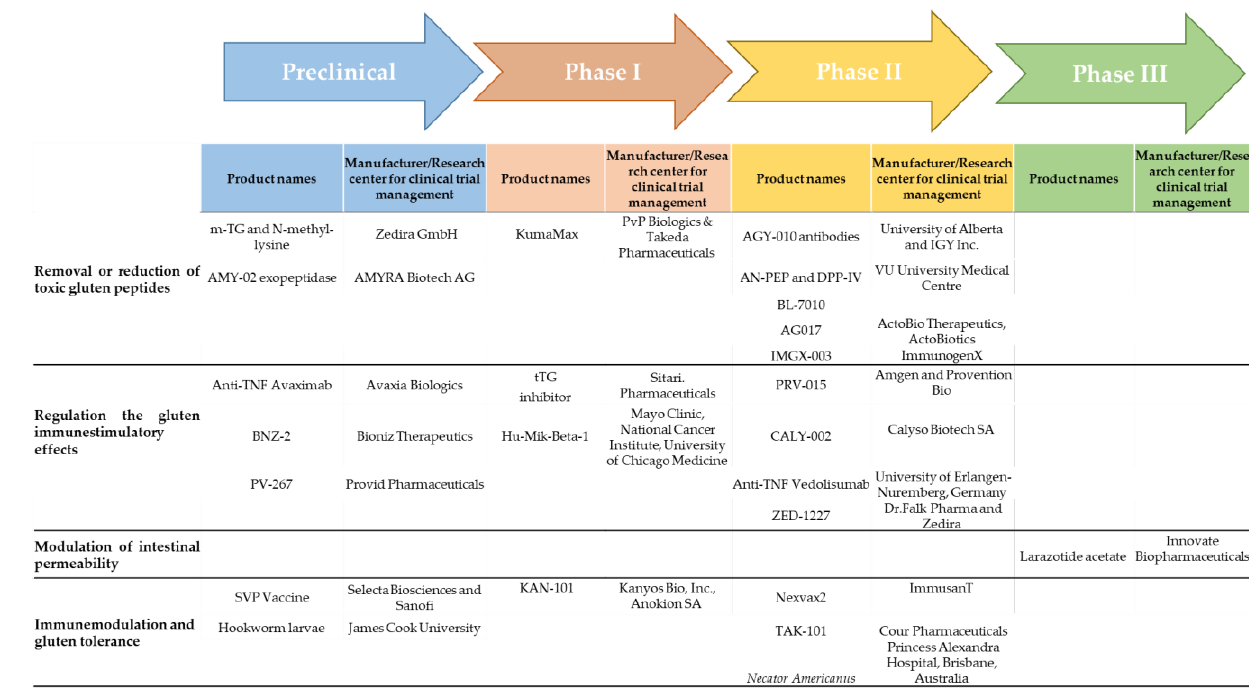
Figure 3. Clinical and preclinical development pipeline for CD. CD, celiac disease; PEP, prolyl endopeptidases; TNF, tumor necrosis factor; tTG, tissue transglutaminase.